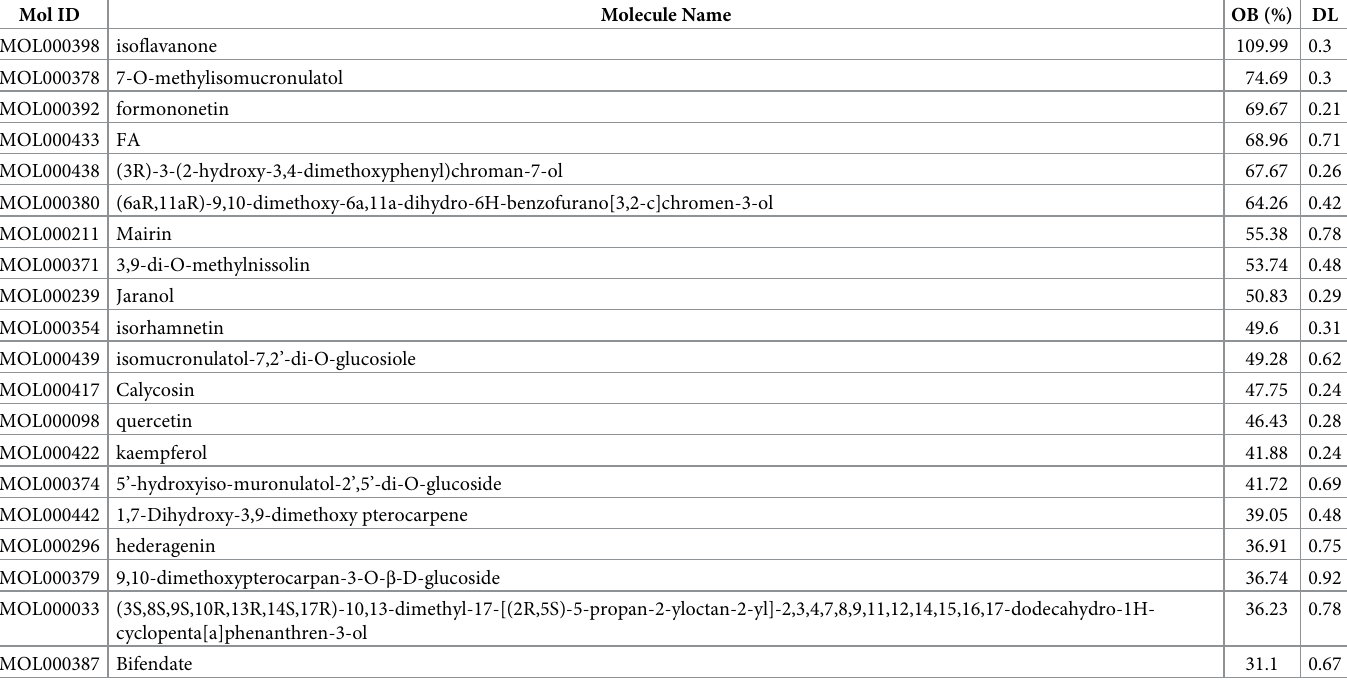
Table 2. Active compounds in